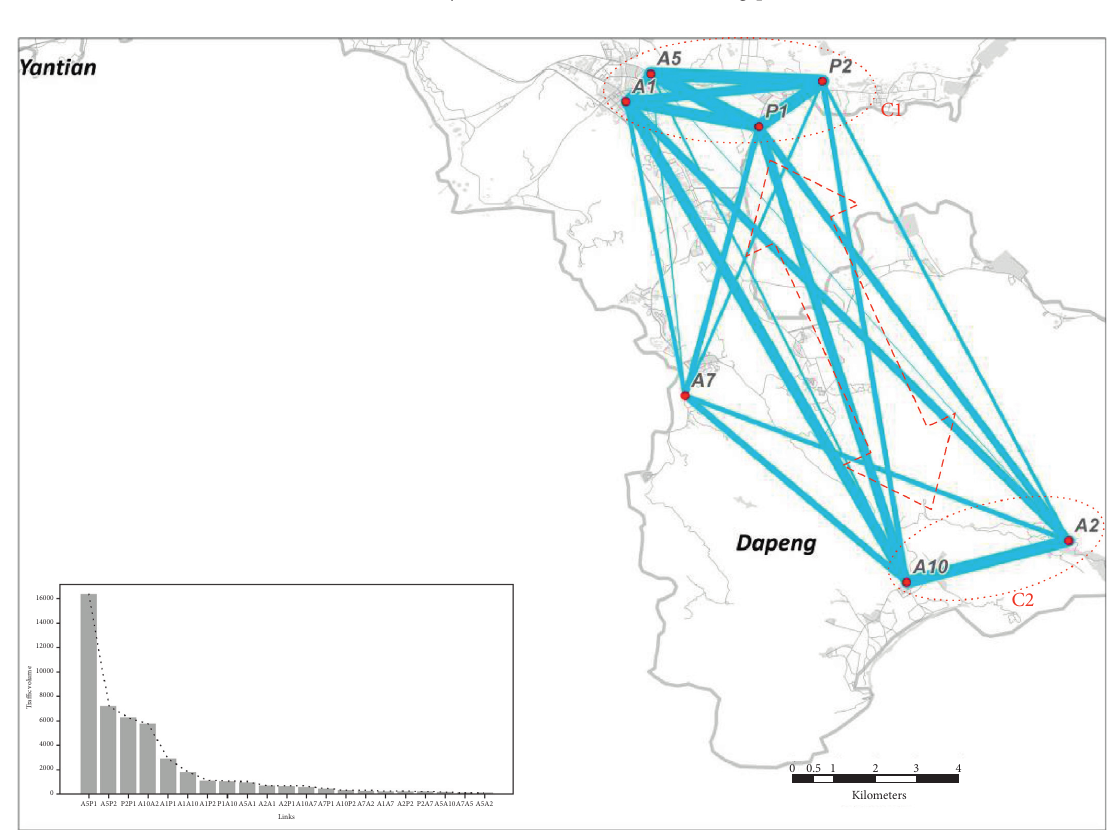
Figure 6: Daily traffic flow at each monitoring point.